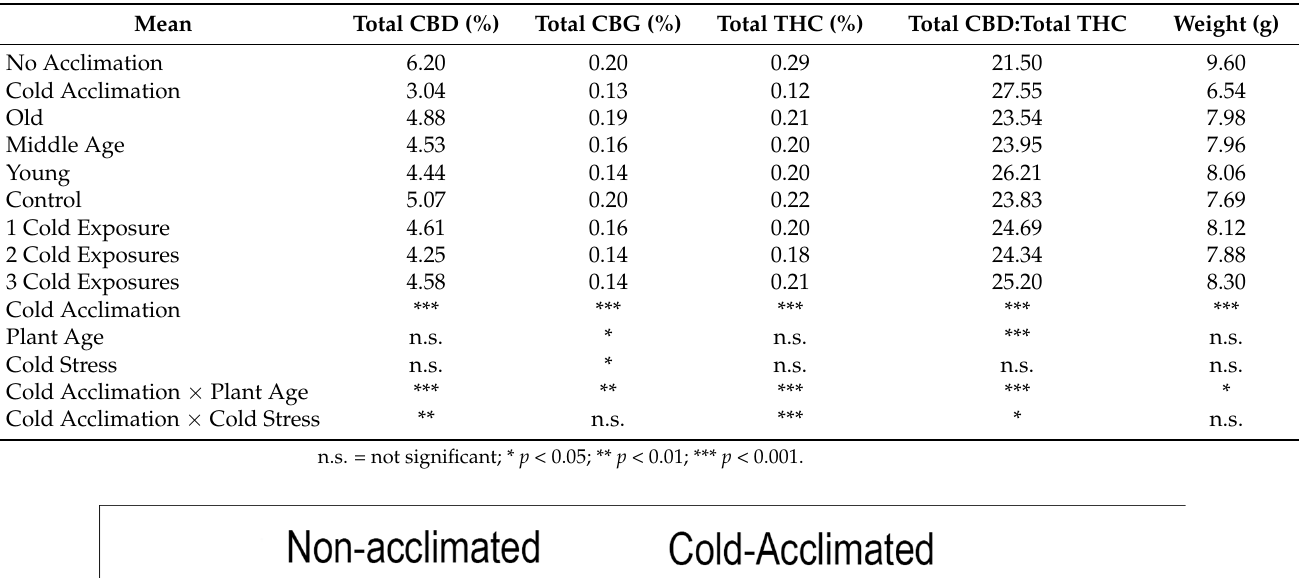
Table 4. Summary of effects of cultivar, cold acclimation, plant age, whole-plant cold stress, and their interactions and mean values for post-harvest properties of ‘AutoCBD’.